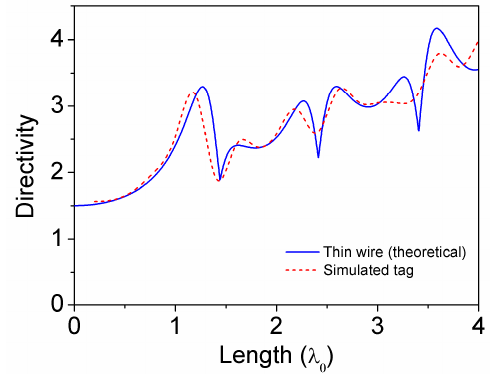
Figure 1 . Directivity of a wire antenna as a function of its electrical length. Figure 1. Directivity of a wire antenna as a function of its electrical